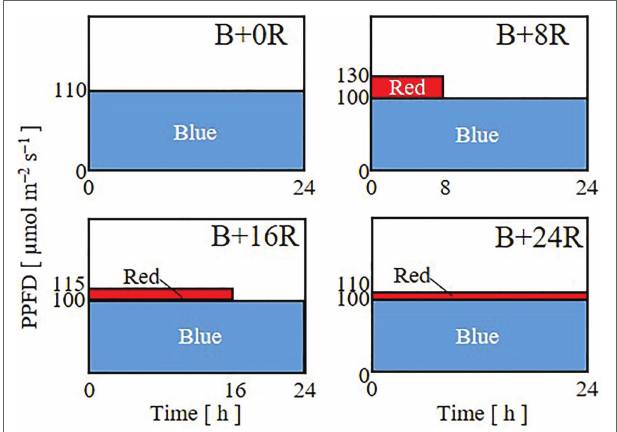
FIGURE 1 | Lighting patterns used in Experiment 1. Plants were subjected to 24-h blue-light irradiation with a PPFD of 110 μ mol m − 2 s − 1 (B + 0R) or under 8 (B + 8R), 16 (B + 16R), or 24-h (B + 24R) red-light irradiation with PPFDs of 30, 15, and 10 μ mol m − 2 s − 1 , respectively, supplemented with 24-h blue-light irradiation with a PPFD of 100 μ mol m − 2 s − 1